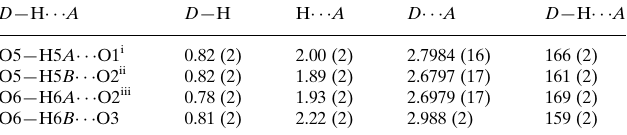
Hydrogen-bond geometry (A˚ , (cid:2) ). D —H (cid:3)(cid:3)(cid:3)